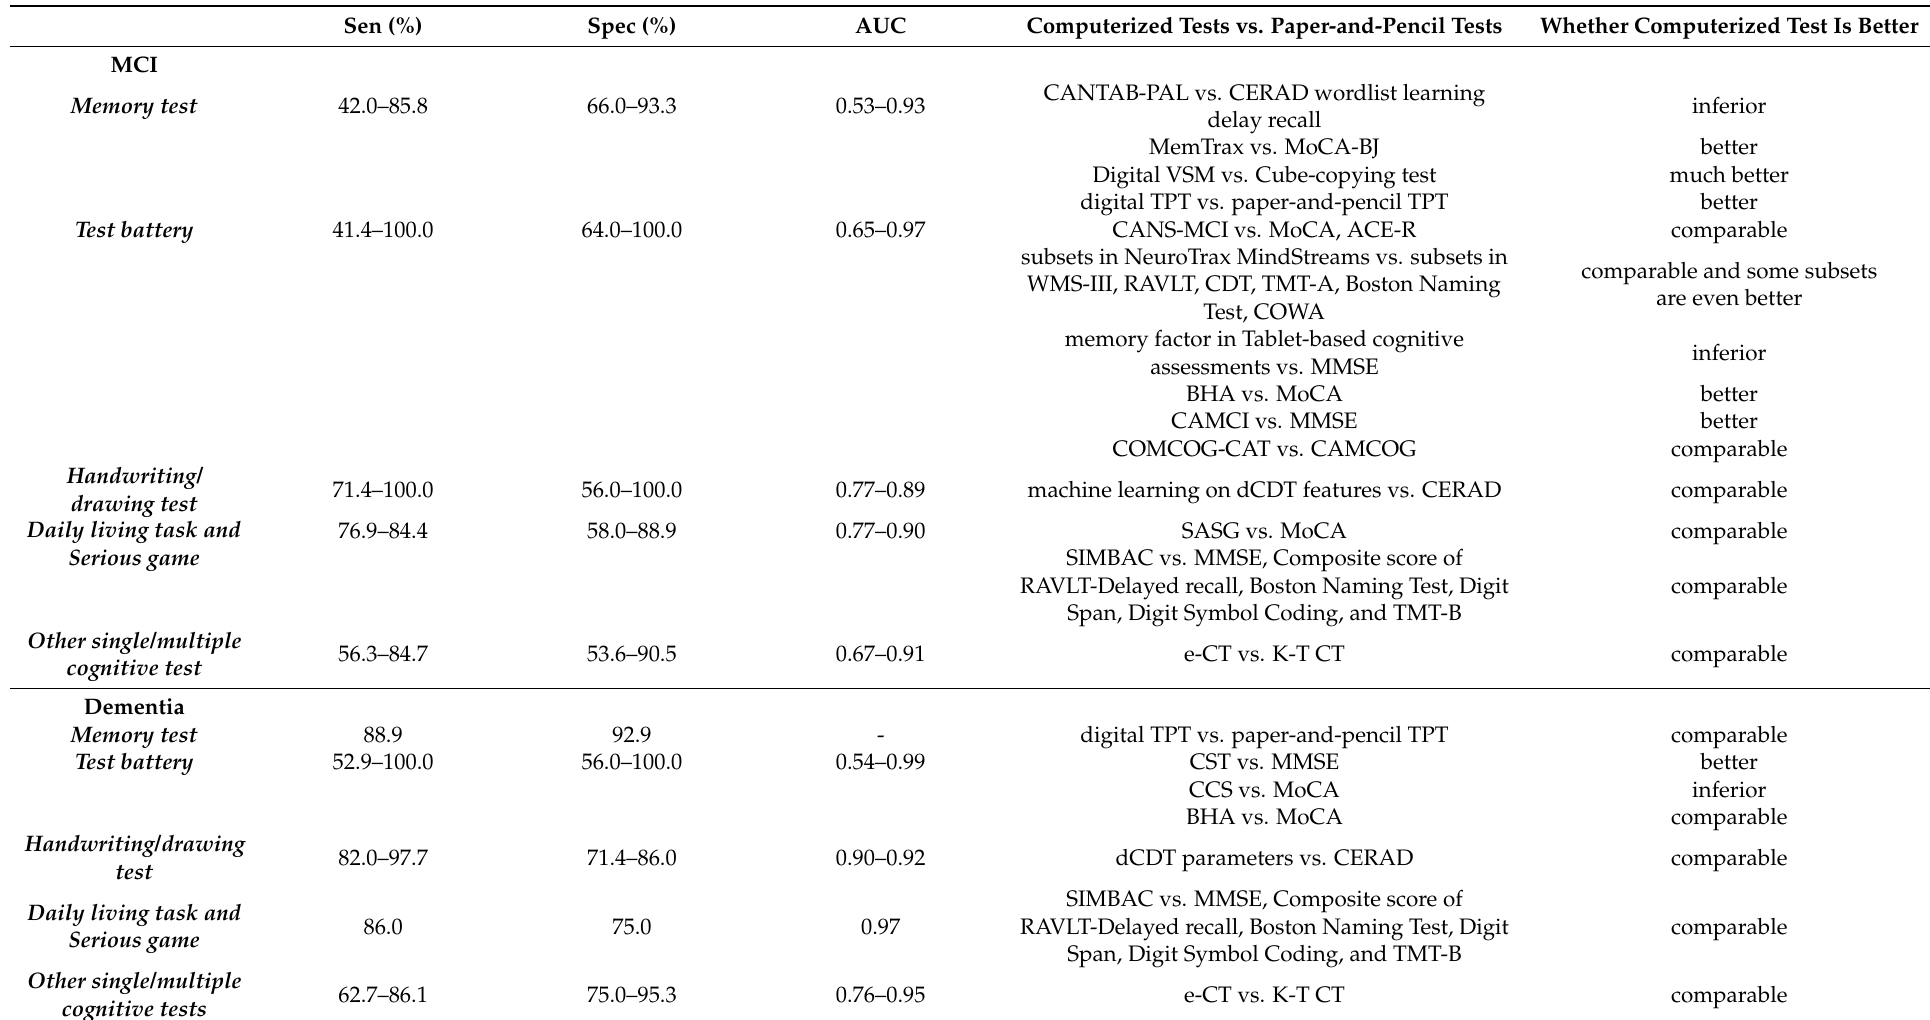
Table 2. Summary on diagnostic performance of computerized tests and the comparison paper-and-pencil